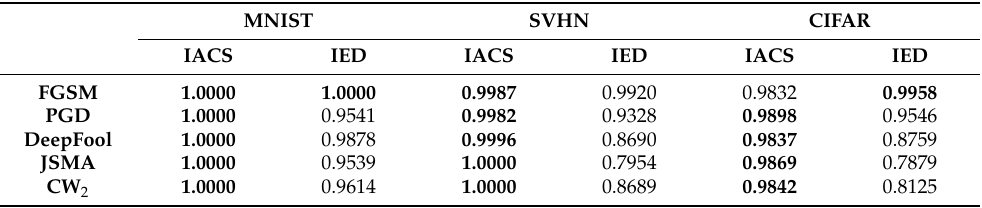
Table 6. A comparison of discrimination power between IACS and IED method on the different datasets and with different attacks. The best results are highlighted in